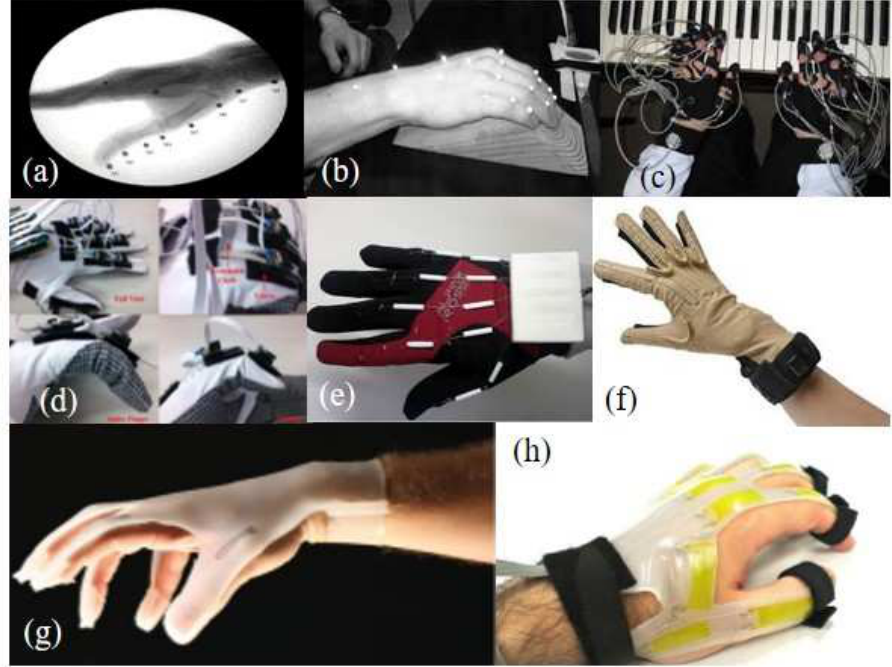
Figure 1. Examples of finger motion measurement systems: ( a ) X-ray based system [2]; ( b ) Infrared (IR) camera based system [3]; ( c ) Three dimensional position sensor system [4]; ( d ) Optical linear